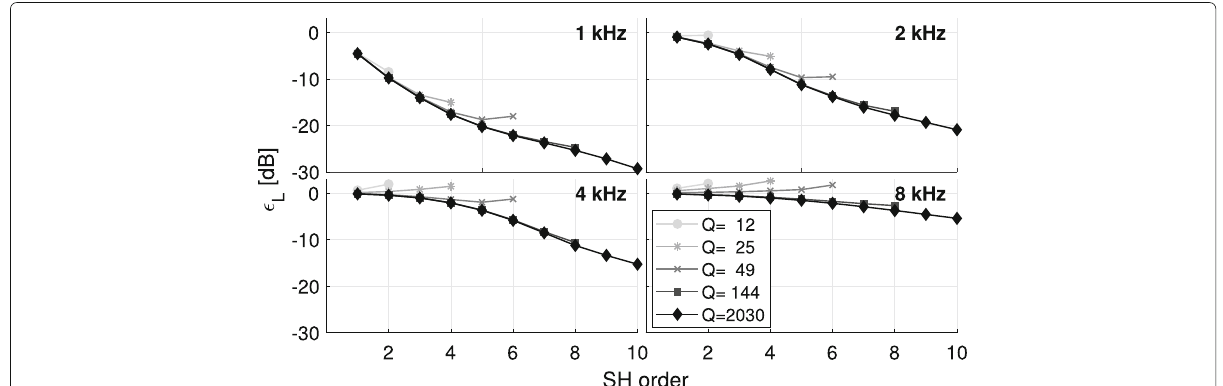
Fig. 3 Error, (cid:8) L , for left ear HRTF, computed using Eq. (12) for each octave band, with different numbers of measurement points and different SH orders